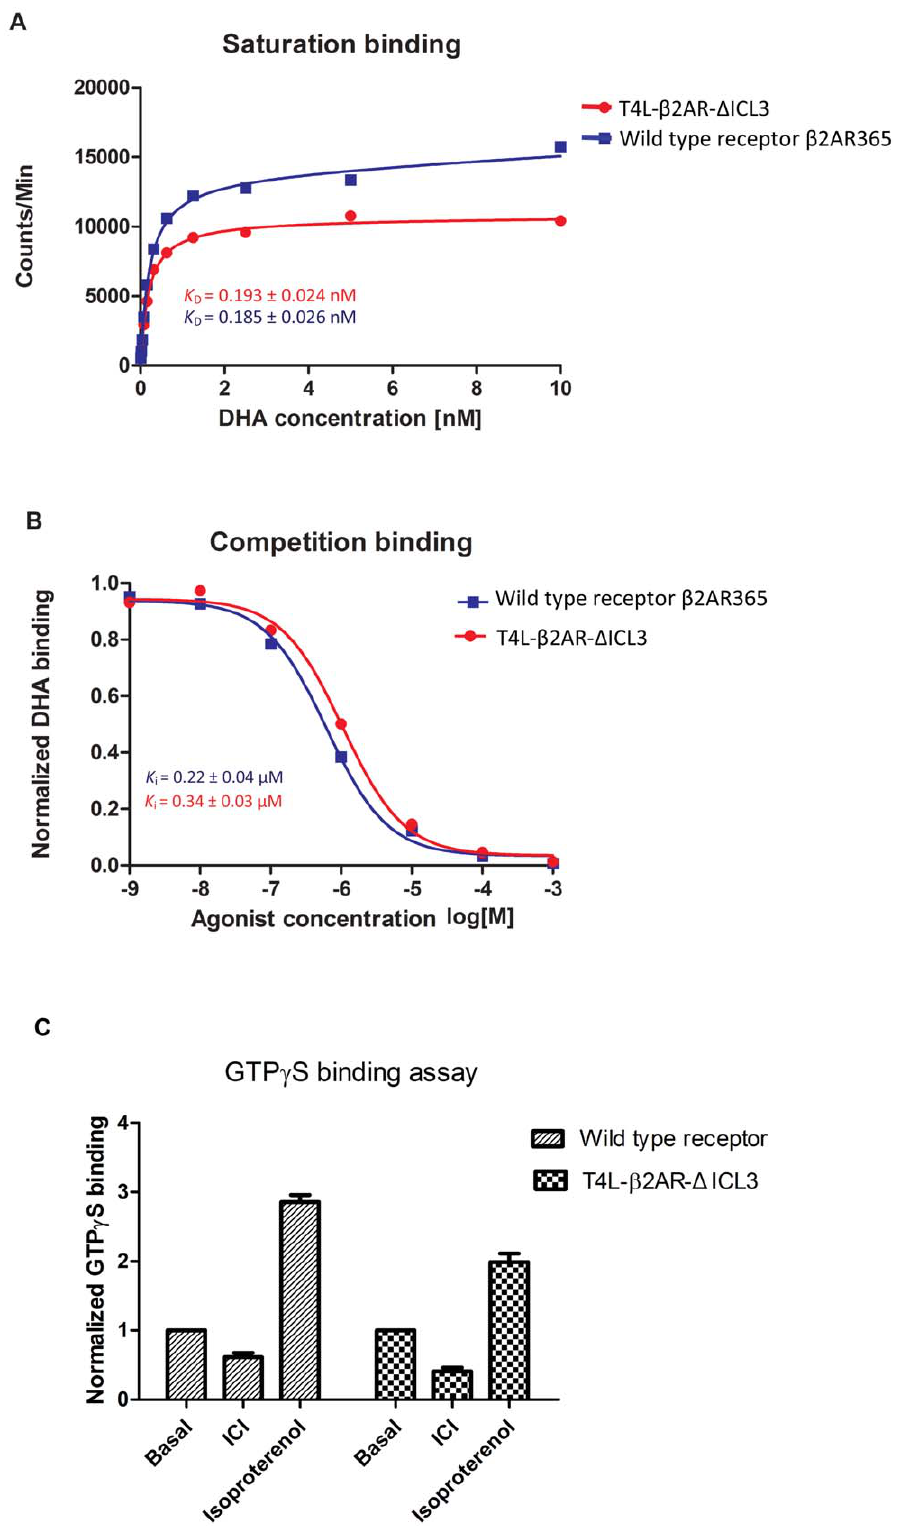
Figure 3. Biochemical characterization of the modified b 2 AR. A. Saturation binding analysis for the antagonist [ 3 H]dihydroalprenolol (DHA) binding to T4L- b 2 AR- D ICL3 and the wild type b 2 AR365. B. Competition binding analysis for the agonist isopreterenol competing for binding of DHA to T4L- b 2 AR- D ICL3 and the wild type b 2 AR365. C. GTP c S binding to the G protein Gs mediated by T4L- b 2 AR- D ICL3 and the wild type b 2 AR365 in the presence of different ligands. Receptors and G proteins were reconstituted into HDL particles as described in Materials and Methods.